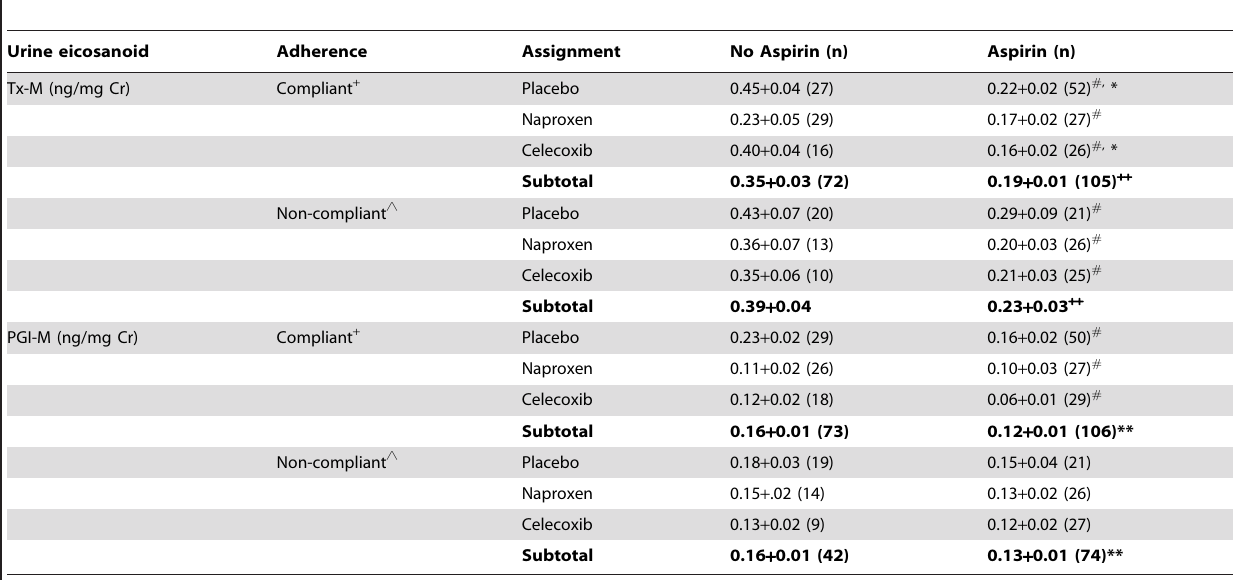
Table 1. Urine Tx-M and PGI-M concentrations in ADAT participants categorized by treatment adherence, group assignment, and aspirin use.